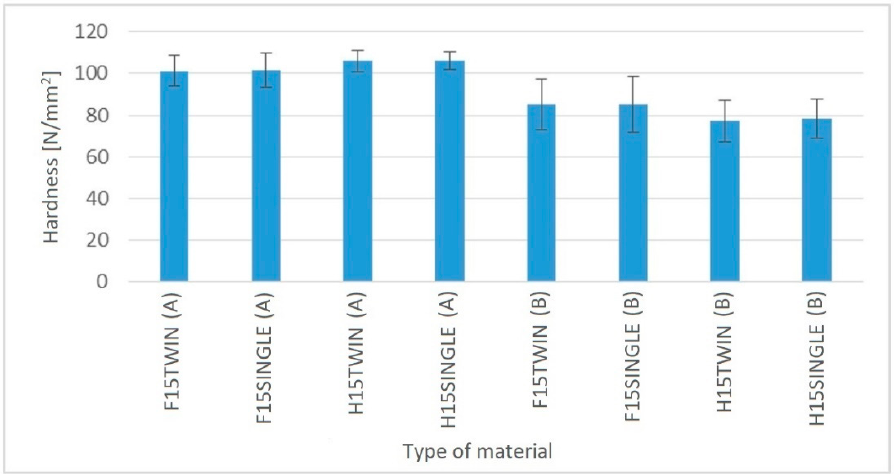
Figure 8. Hardness of PHBV biocomposites produced by single-screw and twin-screw extrusion.